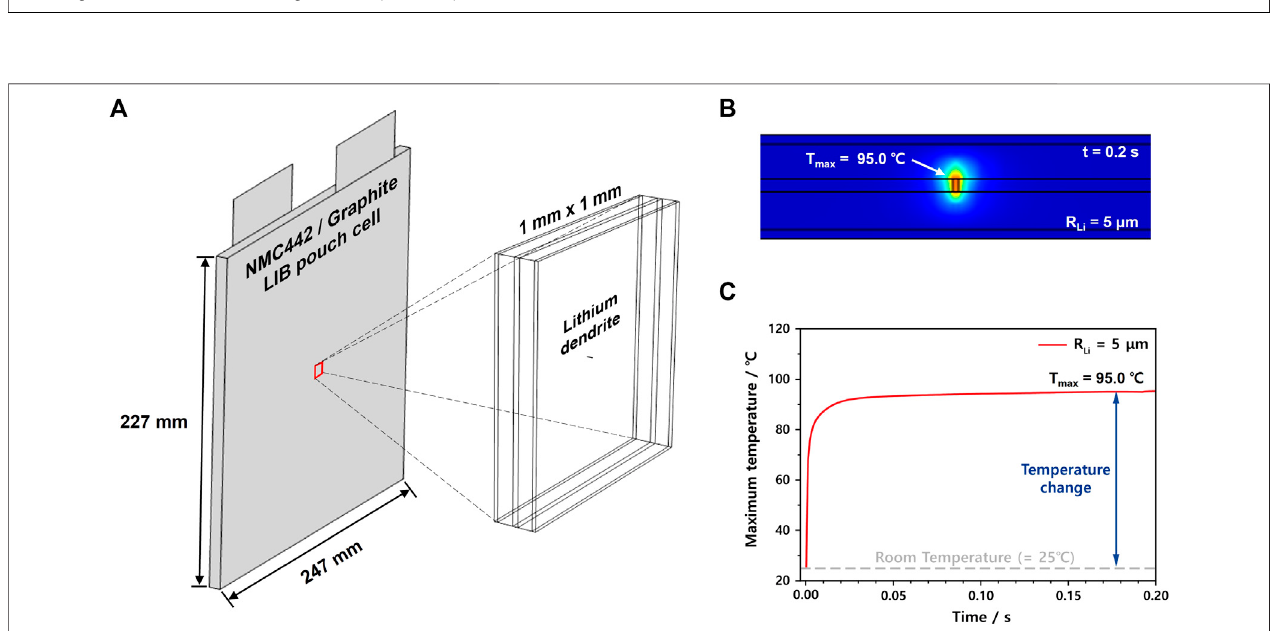
FIGURE 2 | (A) Actual 3D domain size of the ISC model compared to the 50 Ah-level pouch cell. (B) Temperature changes in the cross-sectional domain and (C) maximum temperature changes with time (from 0 to 0.2 s) of the ISC model having a Li dendrite of a radius of 5 μ m.